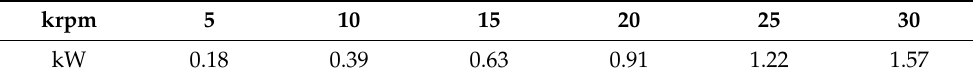
Table 5. Core loss and speed change.